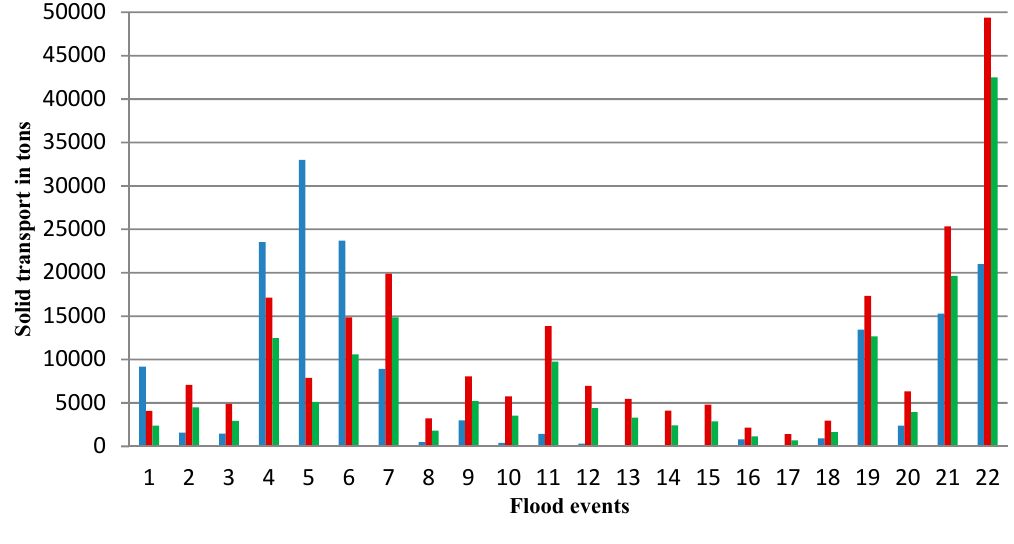
Figure 12. Comparison between MUSLE and observations at Ain Loudah on the Korifla.